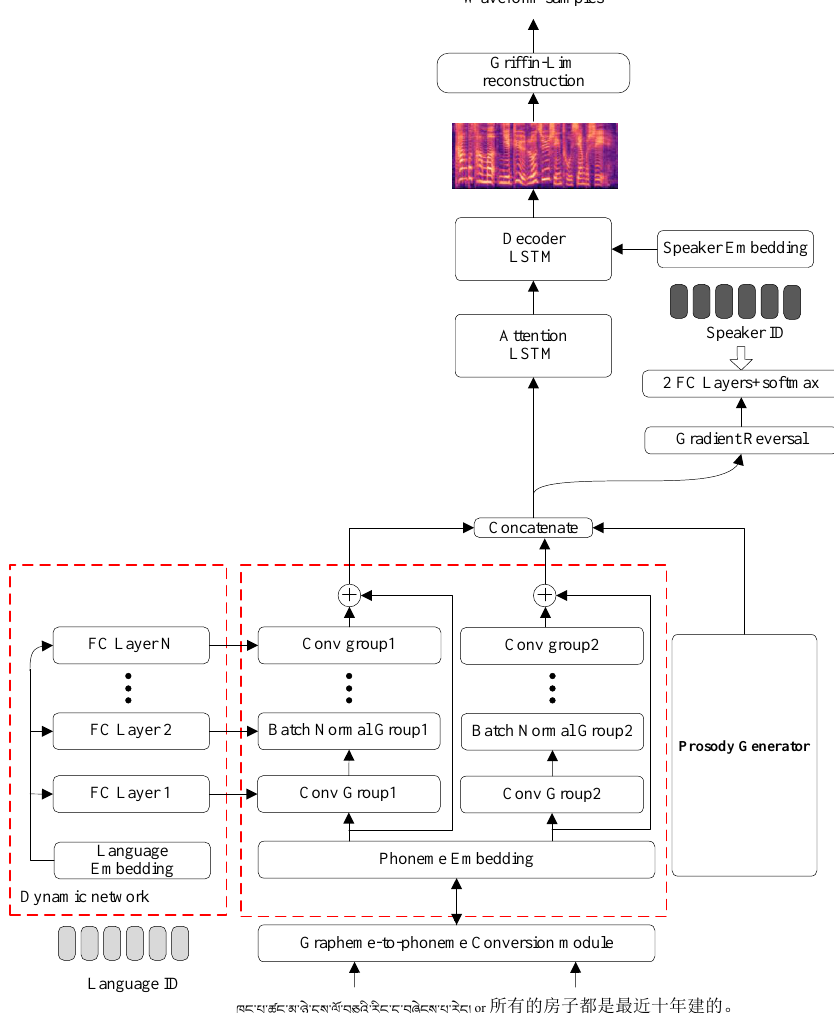
Figure 4. The framework of meta-learning-based Mandarin-Tibetan cross-lingual speech synthesis. We use a dynamic network to predict the parameters of the language-dependent text encoders based on the separate encoder Mandarin-Tibetan TTS. In the figure, the input is a Tibetan sentence (left) or a Chinese sentence (right), which means that all houses have been built in the last ten